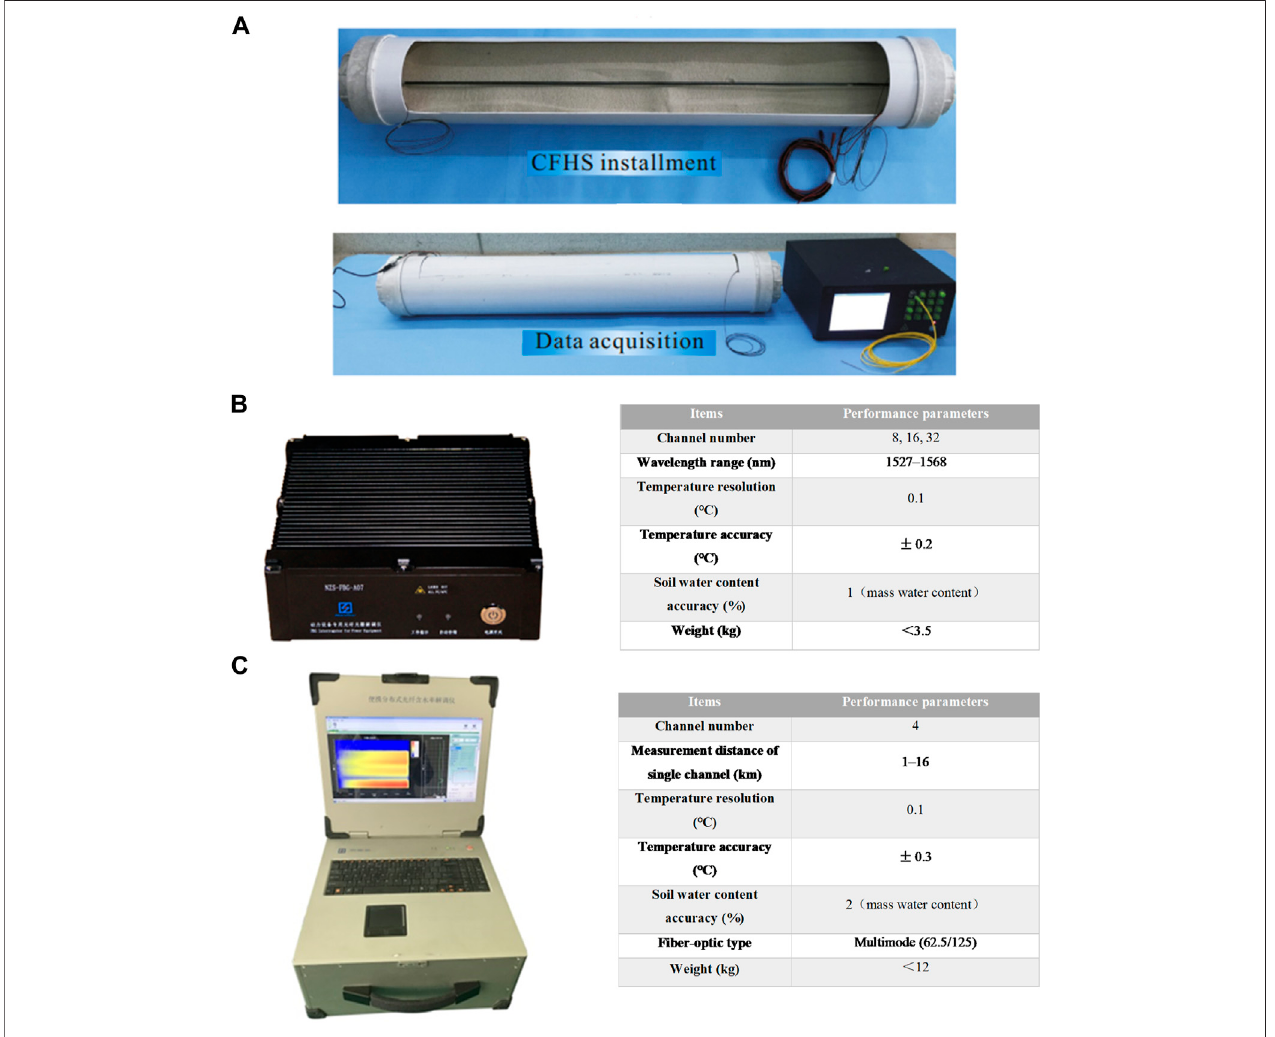
FIGURE 5 | Calibration device and demodulators. (A) Calibration device made of PVC pipe (Cao et al., 2018c). (B) NZS-FBG-A07 demodulator used for AH-FBG sensors and its technical parameters. (C) NZS-DMS-A03 demodulator used for AH-DTS sensors and its technical parameters.